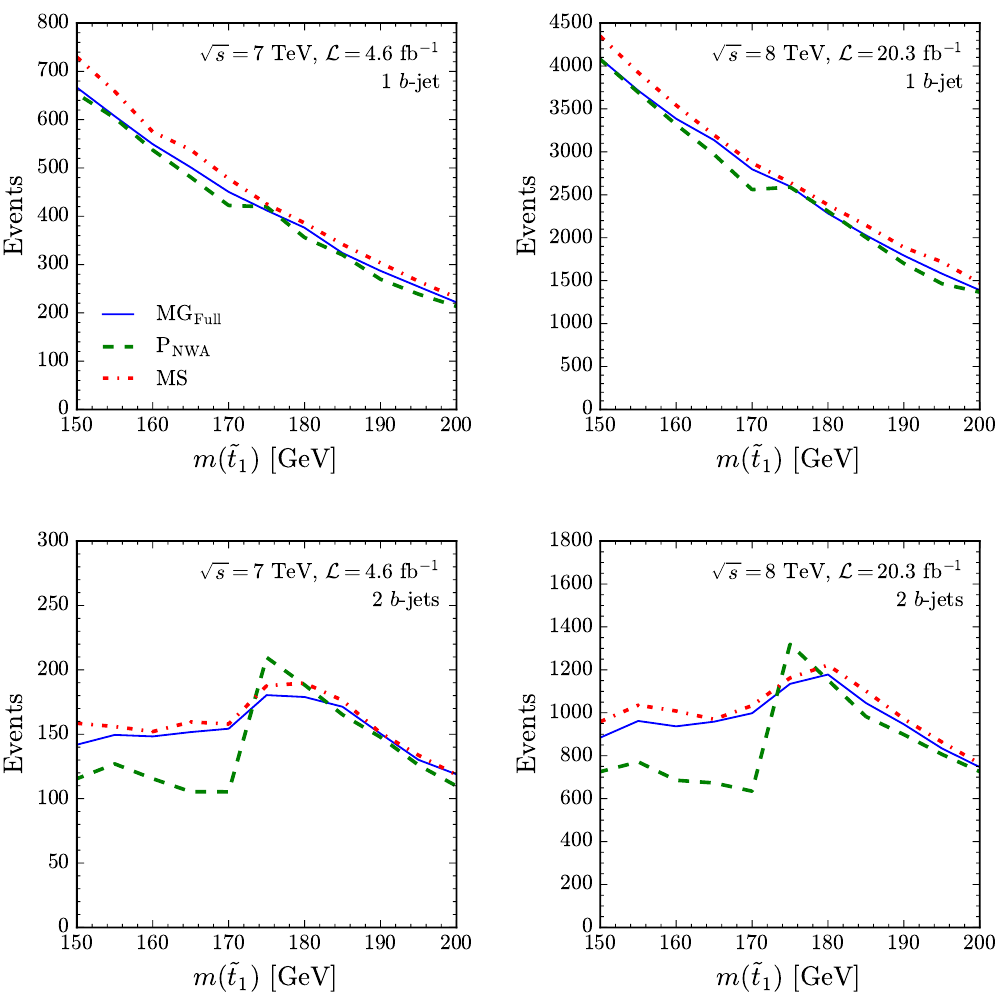
Figure 8 . The upper and lower panels show the number of events coming from stop pair production containing opposite sign e (cid:22) in the one and two b -tagged bins, respectively. The left and right panels show the two di(cid:11)erent center-of-mass energies, respectively. The three event simulation approaches are summarized in table